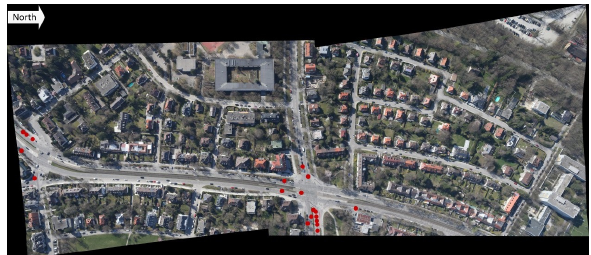
Figure 8. Selected vehicles in areas of crossroads